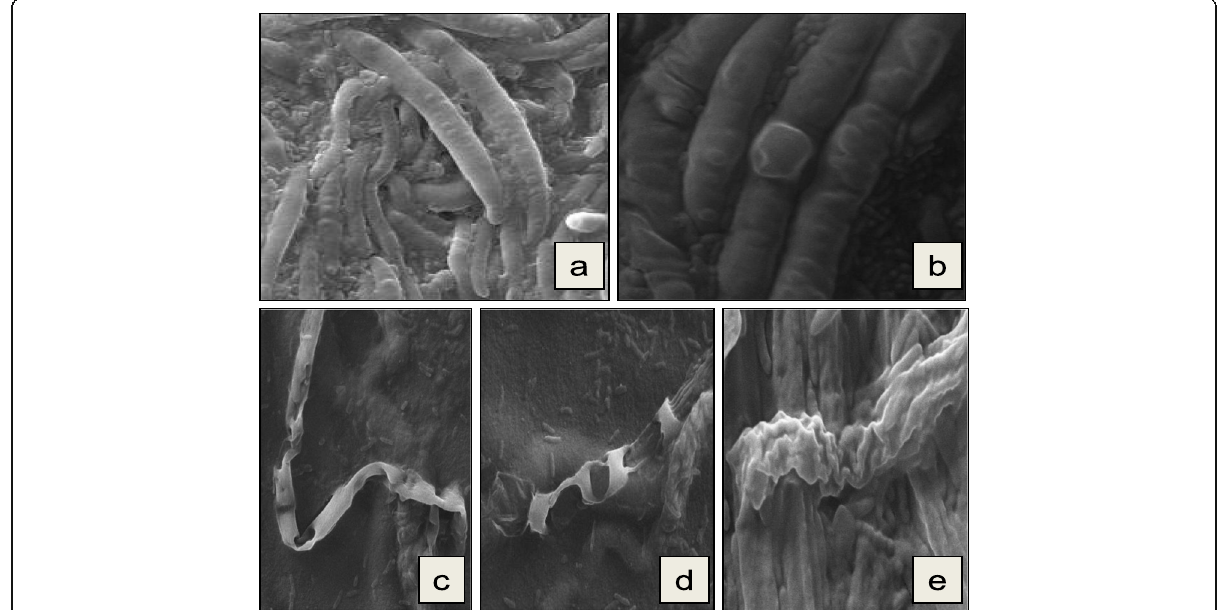
Fig. 5 Electron microscopic scanning photographs showing the antagonistic interaction between chitinolytic bacterial isolates ( Pseudomonas spp. NS-1 and Bacillus spp. NS-22) with the mycelium of Fusarium udum . a Healthy mycelium as seen in untreated control. b , c Irregular shape, bulging, and lysis of pathogen mycelium caused by the bacterium Pseudomonas spp. NS-1. d , e Lysis of mycelia and mycelial distortion caused by the bacterium Bacillus spp.